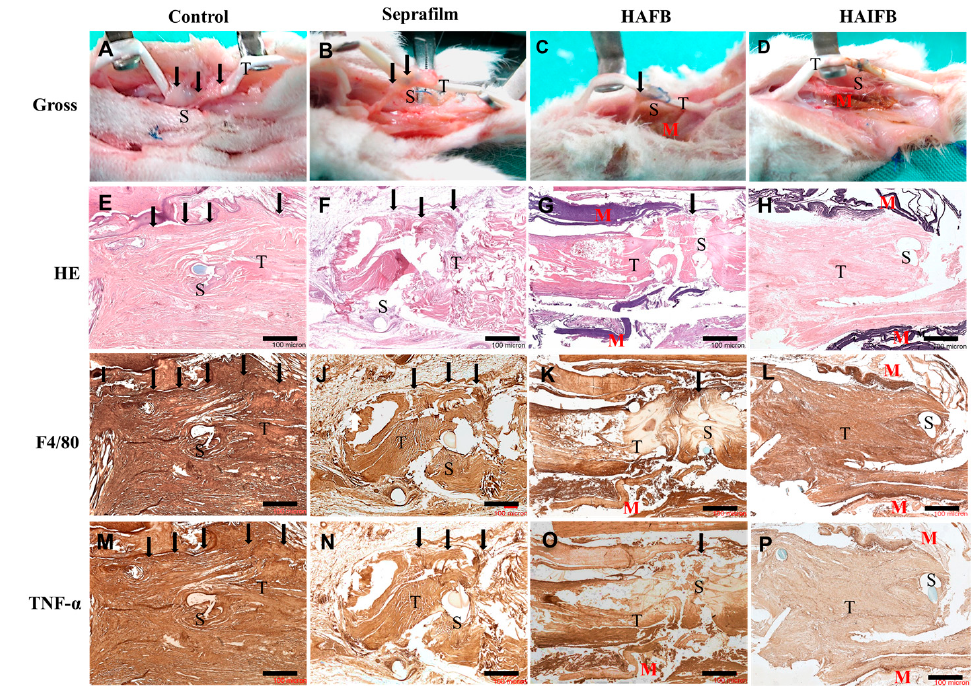
Figure 8. Gross view ( A – D ), H&E ( E – H ), F4 / 80 ( I – L ), and TNF- α ( M – P ) stainings of tissue sections of the repaired flexor digitorum profundus (FDP) tendons of the untreated control group and the experimental groups treated with Seprafilm ® , HAFB, and HAIFB 3 weeks post-operation. Bar = 100 µ m. T: tendon; S: suture; M: membrane; black arrows: sites where adhesion occurred.